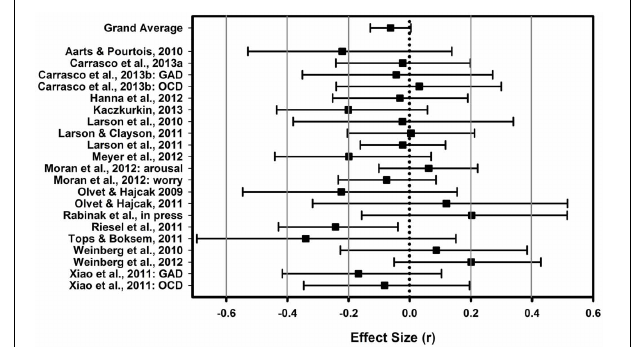
FIGURE 4 | CRN forest. A forest plot depicting effect sizes ( r ) between the CRN and measures of anxiety for the meta-analytic average (top) and